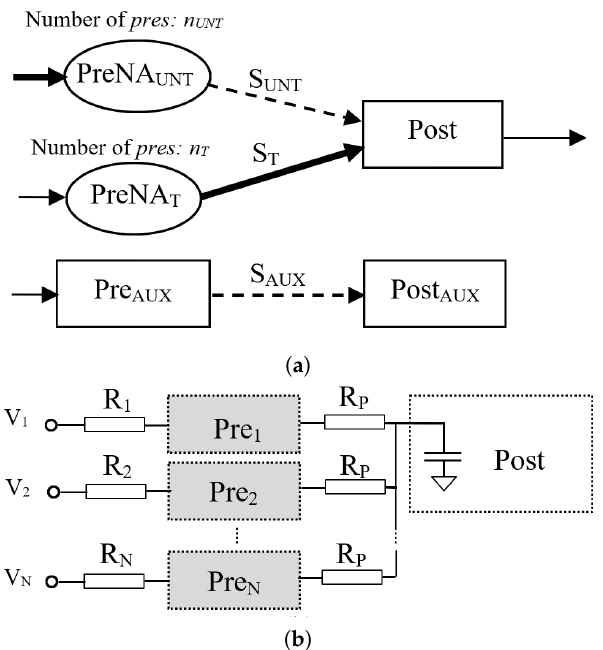
Figure 2. ( a ) The structure of the SNN that was used to perform tests; ( b ) R varied among presynaptic neurons Pre 1, Pre 2, . . . , PreN